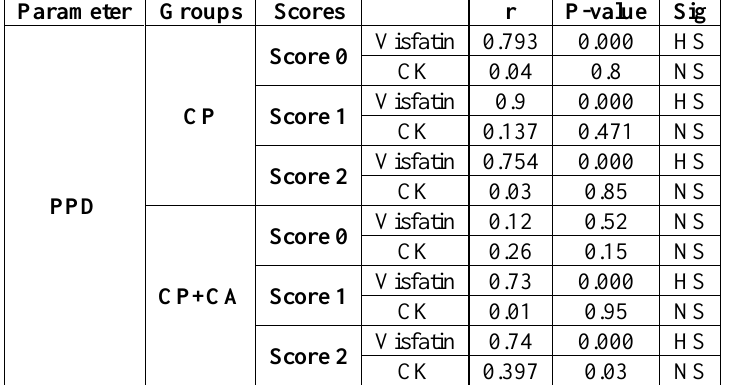
Table 6: Pearson's Correlation Coefficient (r) between PPD Scores and the levels of salivary CK enzyme and visfatin for each study group Parameter Groups